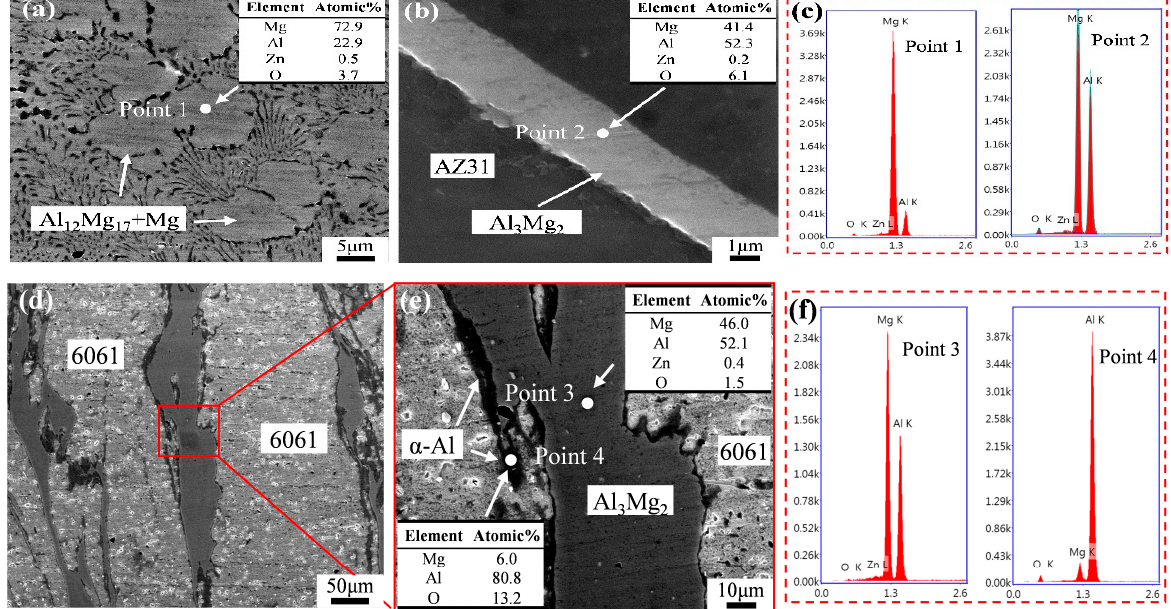
Figure 7. SEM morphology and EDS results at various positions of the joint welded in Configuration Al–Mg at 700 rpm: ( a ) hook tip; ( b ) interface of the SZ bottom at the AS; ( c ) EDS results at points 1 and 2; ( d ) SZ; ( e ) magnified micrograph of ( d ); ( f ) EDS results of points 3 and 4.